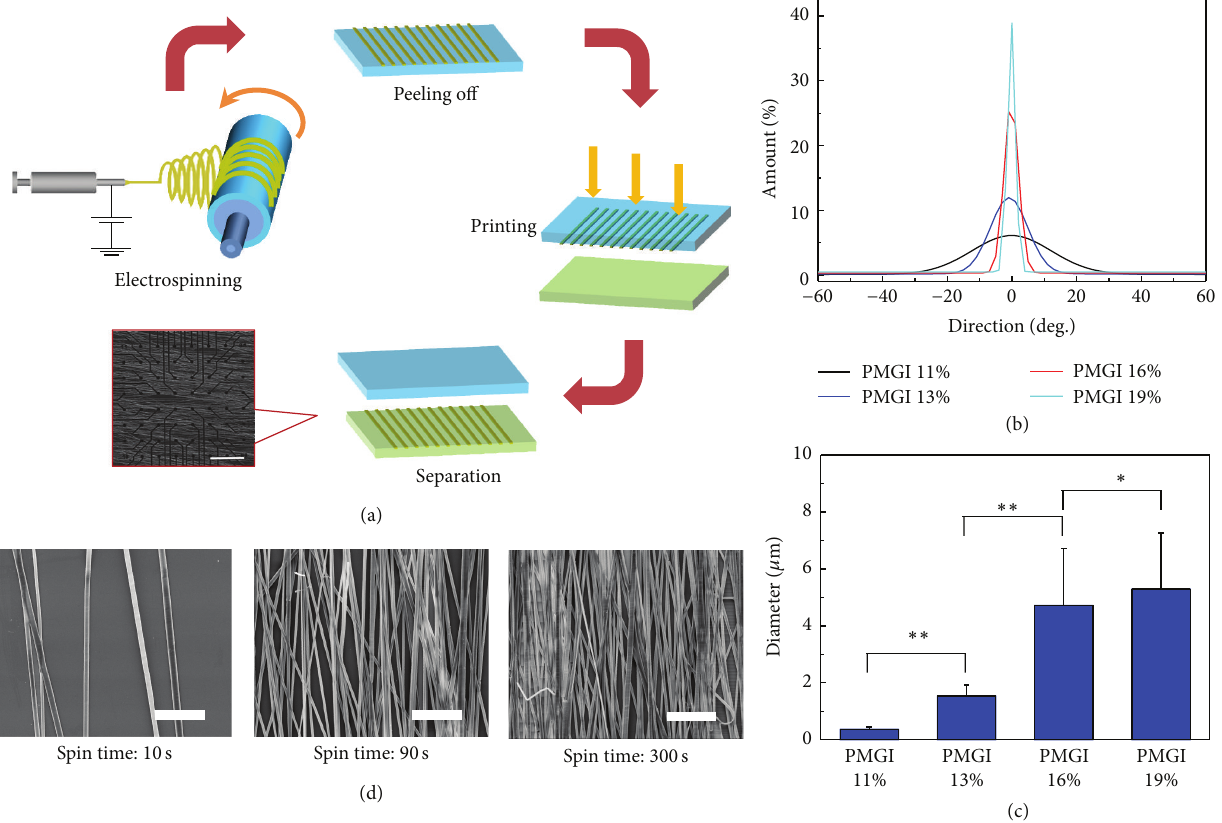
Figure 1: Preparation of aligned PMGI fibers. (a) Schematic of electrospinning and transfer of electrospun nanofibers to the surface of a microelectrode array. The scale bar = 50 𝜇 m. (b) Angular distributions and (c) diameter of fibers generated from PMGI of different concentrations (%). (d) Scanning electron microscopy images of 16% PMGI fibers electrospun for 10, 90, and 300 s. The scale bar = 50 𝜇 m (means ± s.e., 𝑛 = 3 , ∗ 𝑃 < 0.05 , ∗∗ 𝑃 < 0.01